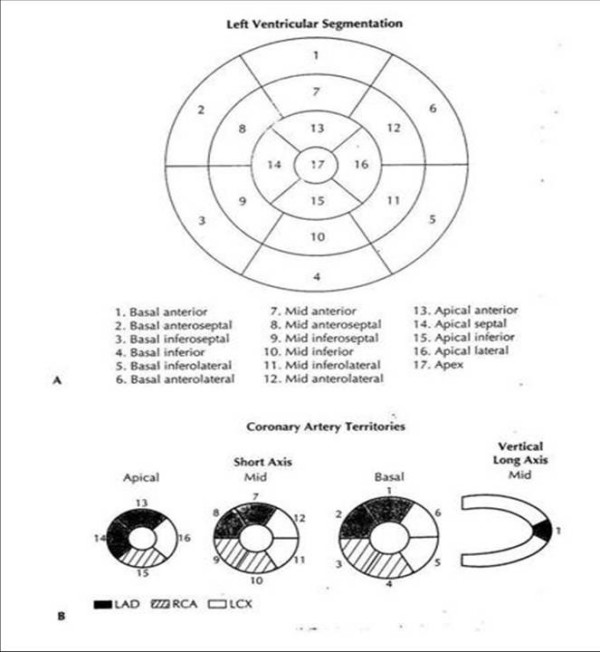
A. A polar-plot depiction of the left ventricular segmentation according to the 17-segment model. The recommended nomenclature is noted for each segment below. B. The 17-segment model, obtained by three individual short-axis slices as well as one midcavity vertical long-axis slice. A depiction of the coronary artery distribution is also noted.